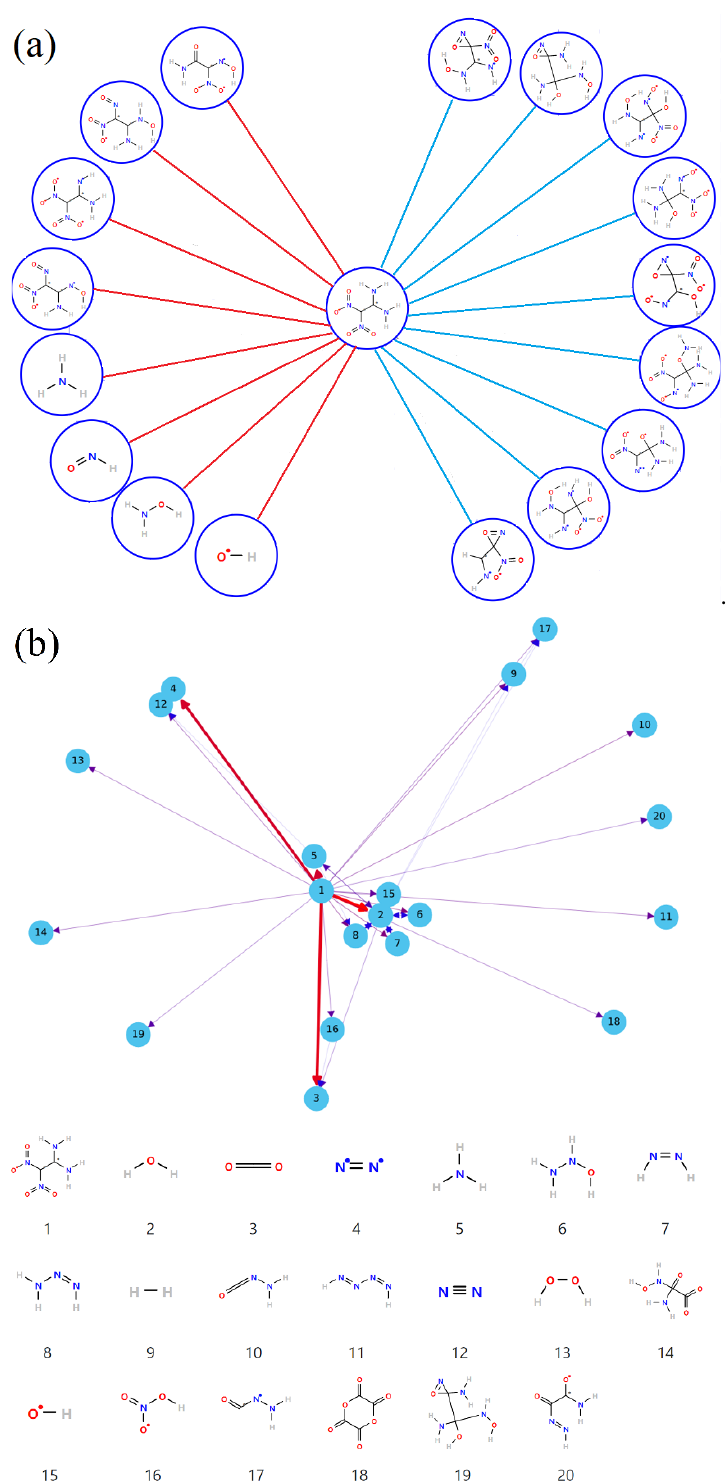
Figure 8. ( a ) The initial decomposition path in s0.8 under 2000 K. ( b ) The reaction network from FOX-7 to H 2 O, CO 2 , N 2 … formed by the top 20